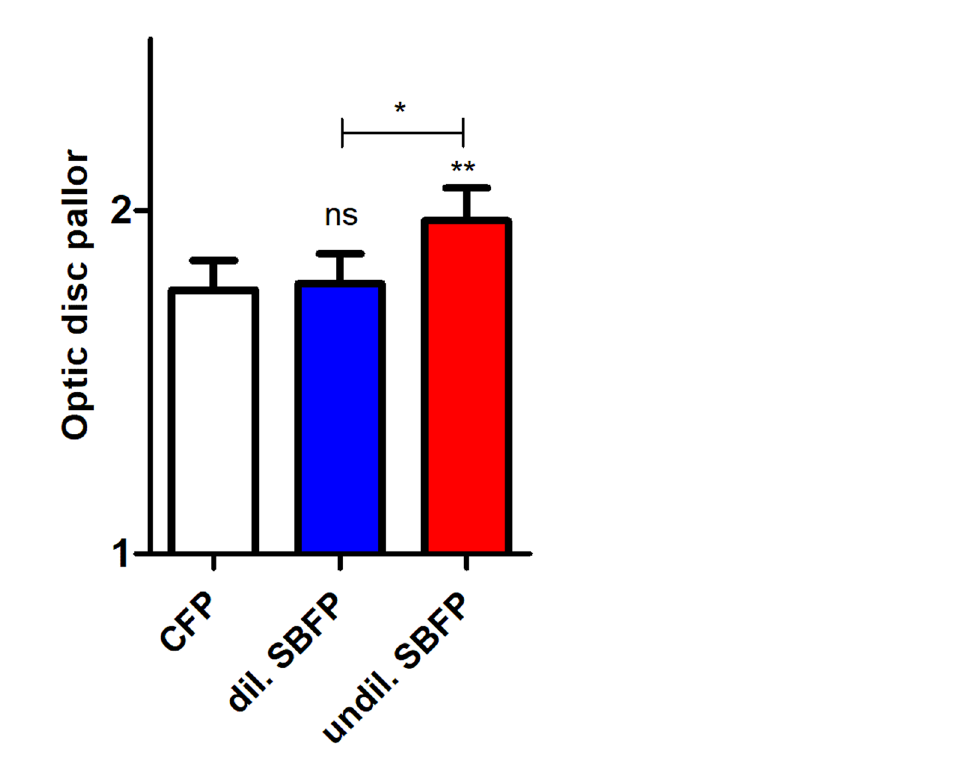
Figure 7. Evaluation of optic disc pallor. Conventional fundus photography (CFP) and dilated (dil.) and undilated (undil.) smartphone-based fundus photography (SBFP) were compared. Error bars indicate standard error of the mean, paired t-test was used for analysis, ns = not significant, * p < 0.05, ** p < 0.01.